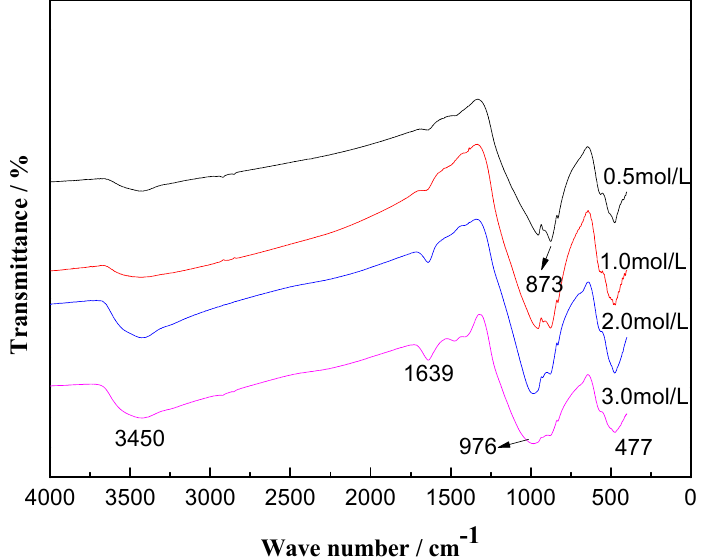
Figure 4. FT − IR spectra of CNS dissolved by solutions with different sodium silicate solution con ‐